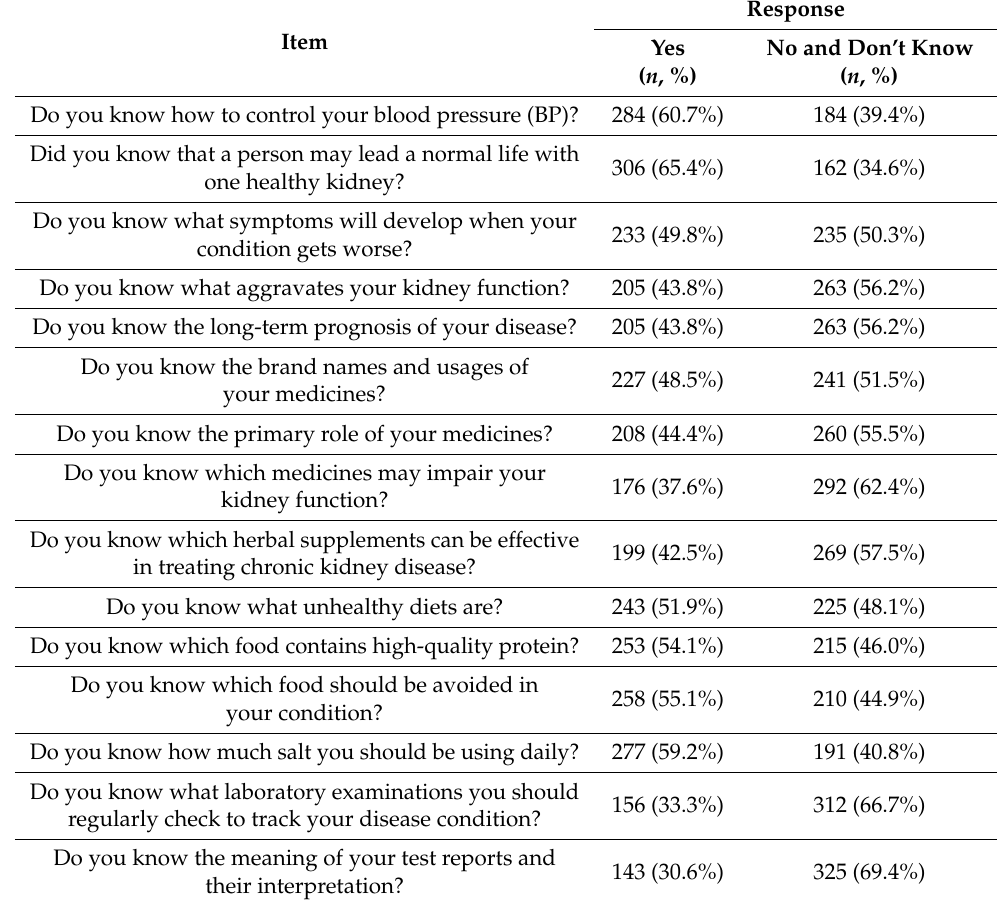
Table 4. Awareness of the participants regarding the CKD disease condition and associated factors.